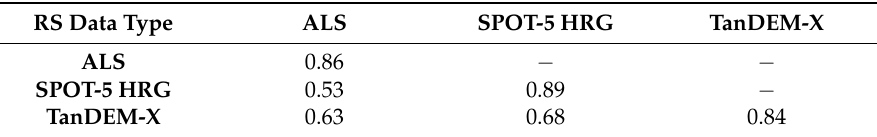
Table 5. Average correlation for the residuals of mean